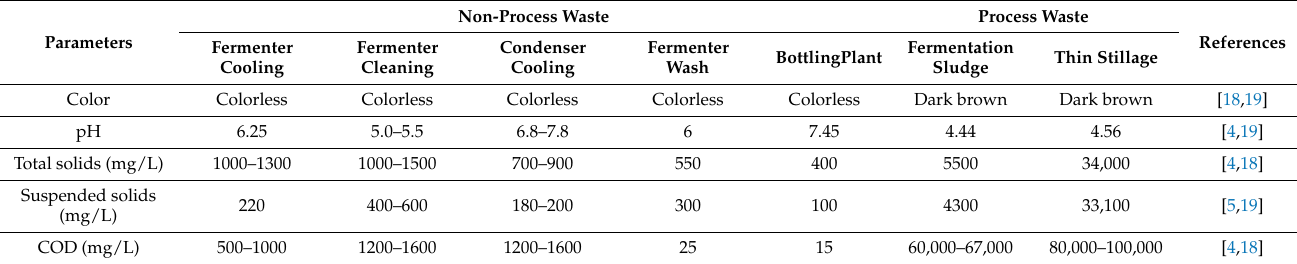
Table 1. Chemical and physical characteristics of process and non-process